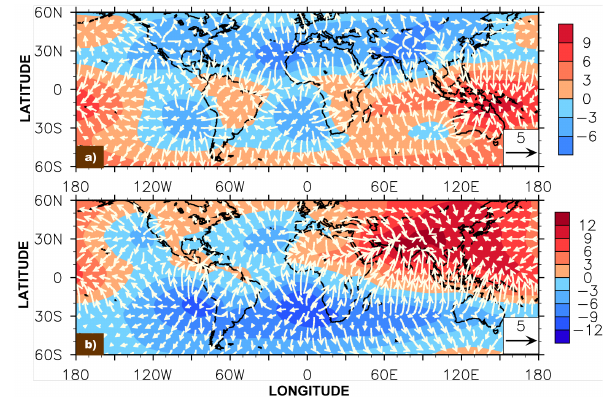
Fig. 4. Distributions of the monthly mean velocity potential (shad- ing, unit is 10 − 6 m 2 s − 1 ) and divergent wind (arrows, ms − 1 ) at 1000hPa in January (a) and July (b)